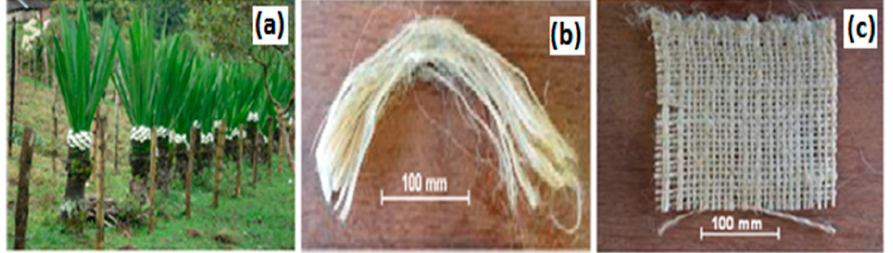
Figure 1. Plantation of fique ( Furcraea andina ) in Colombia ( a ), bundle of fique fibers ( b ), and as-received piece of fique fabric ( c ).